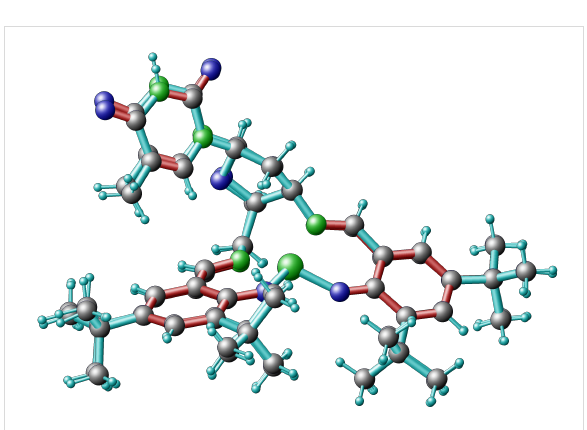
Figure 2: This figure shows an overlay of the two complex molecules contained in the asymmetric unit.